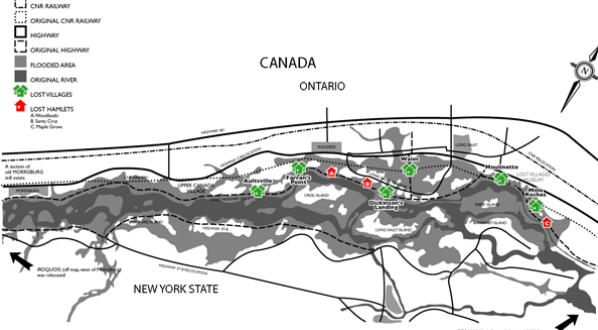
Figure 2. Map of Lake St.